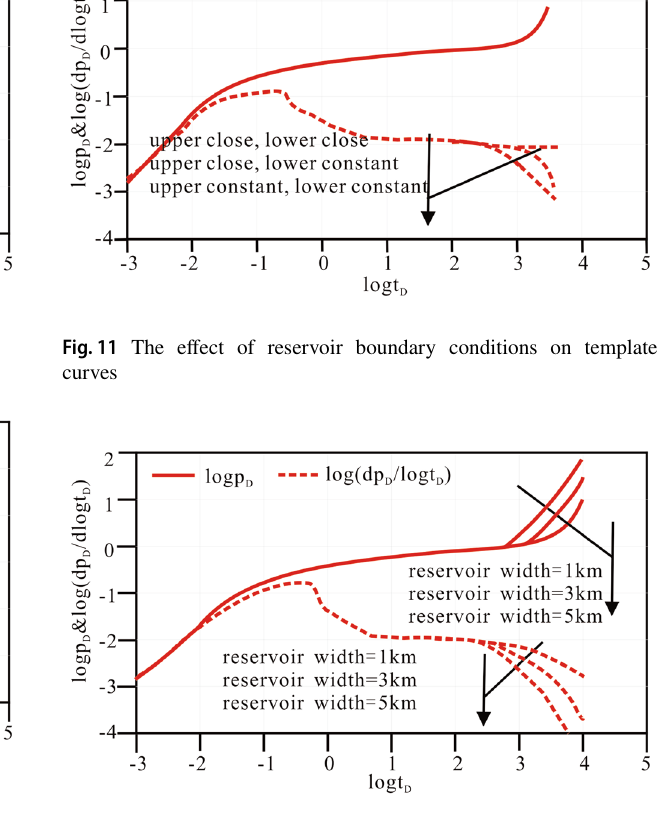
Fig. 12 The effect of reservoir width on template